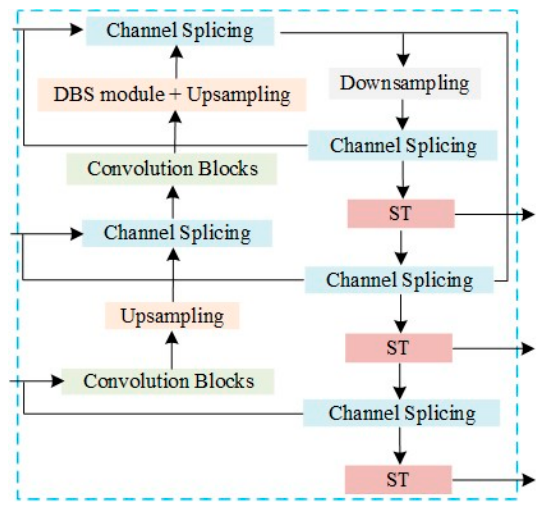
Figure 9. ST-YOLOv5 enhanced feature extraction network.